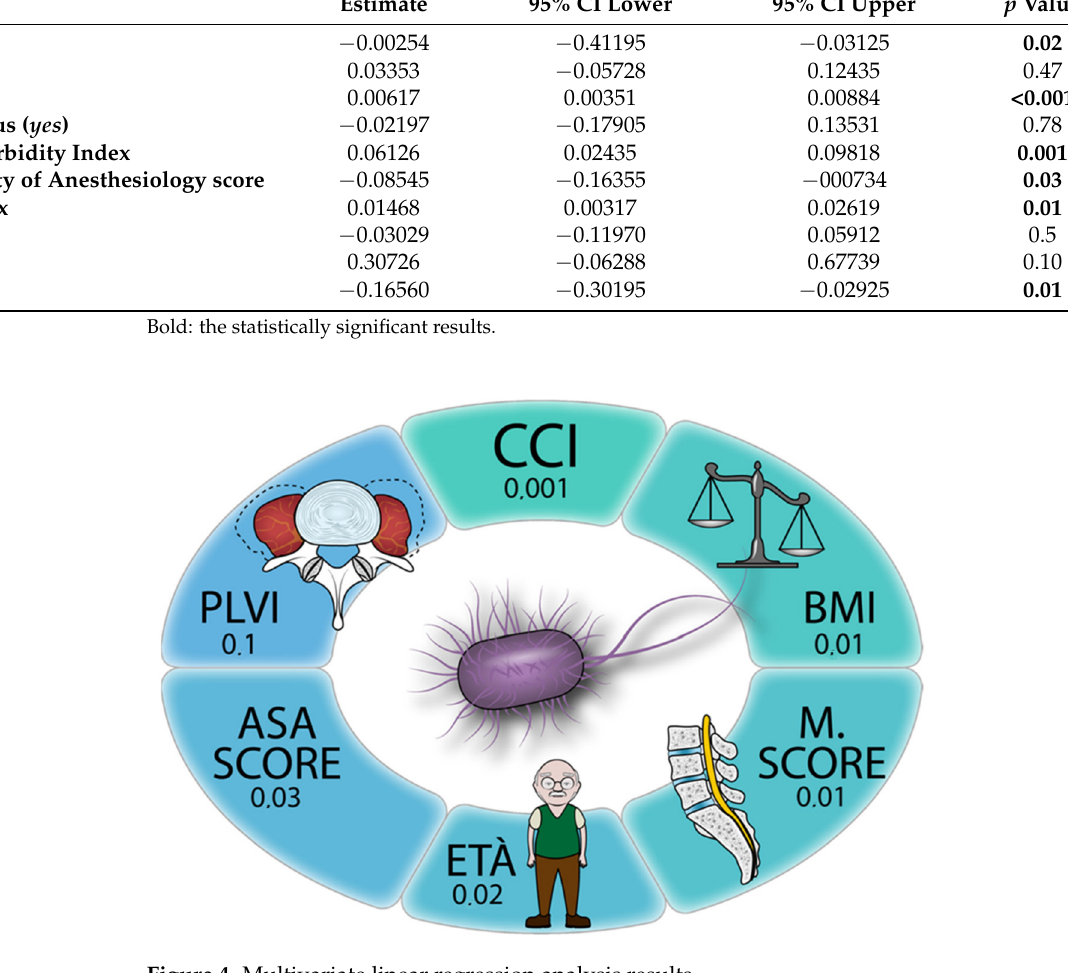
Figure 4. Multivariate linear regression analysis